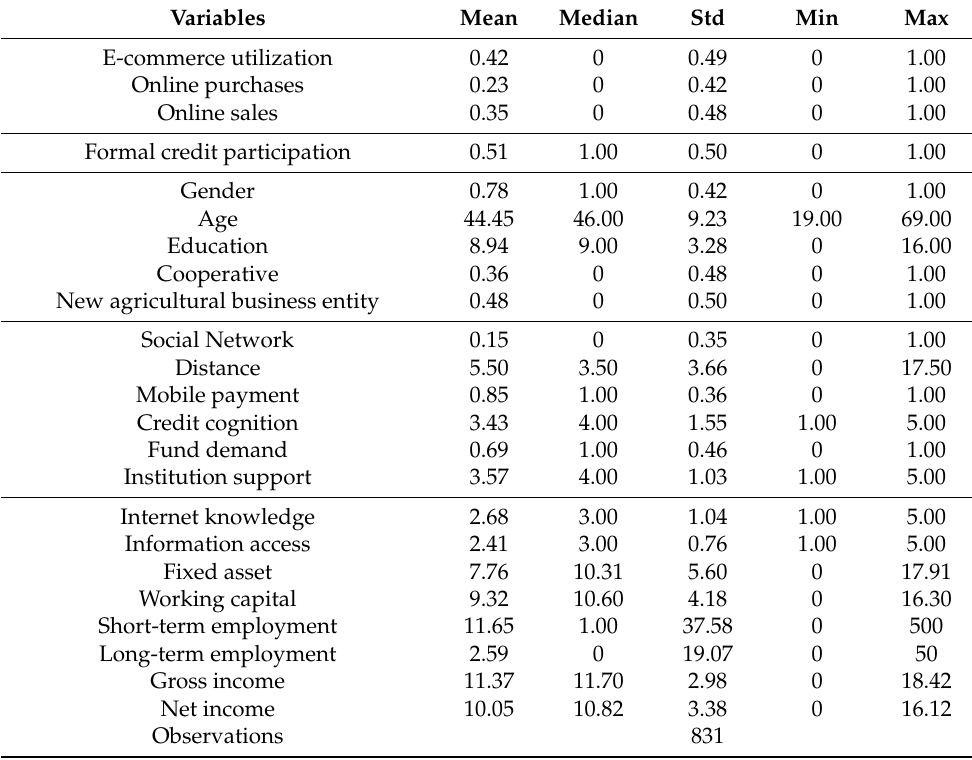
Table A1. Summary statistics of variables.